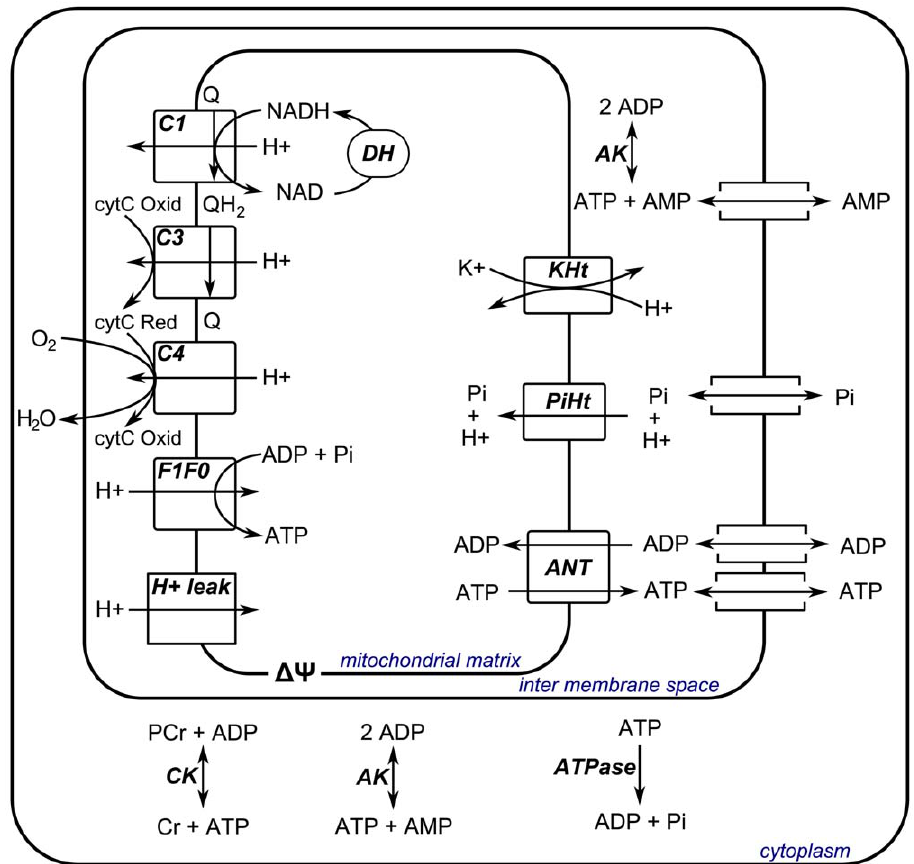
Figure 7. Schematic representation of the computational model of skeletal muscle energetics. Abbreviations denote: dehydrogenases (DH), complex I (C1), complex III (C3), complex IV (C4), F 1 F 0 ATPase (F1F0), proton leak (H + leak), adenine nucleotide transporter (ANT), Pi-H + transporter (PiHt), K + - H + transport (KHt), adenylate kinase (AK), creatine kinase (CK), lumped cellular ATPase fluxes (ATPase), ubiquinone (Q), ubiquinol (QH2), oxidized cytochrome C (cytC Oxid), reduced cytochrome C (cytC Red), adenosine diphosphate (ADP), inorganic phosphate (Pi), adenosine triphosphate (ATP), nicotinamide adenine dinucleotide (NAD), reduced nicotinamide adenine dinucleotide (NADH), adenosine monophosphate (AMP).